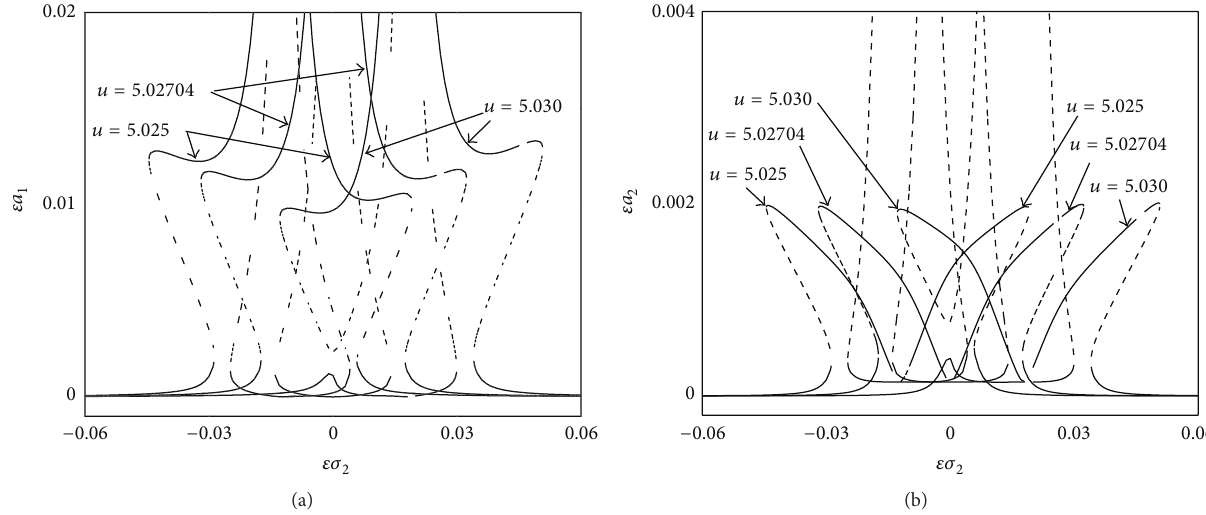
Figure 17: Amplitude-frequency curves of the difference resonance for different flow speeds: (a) the first mode and (b) the second mode.